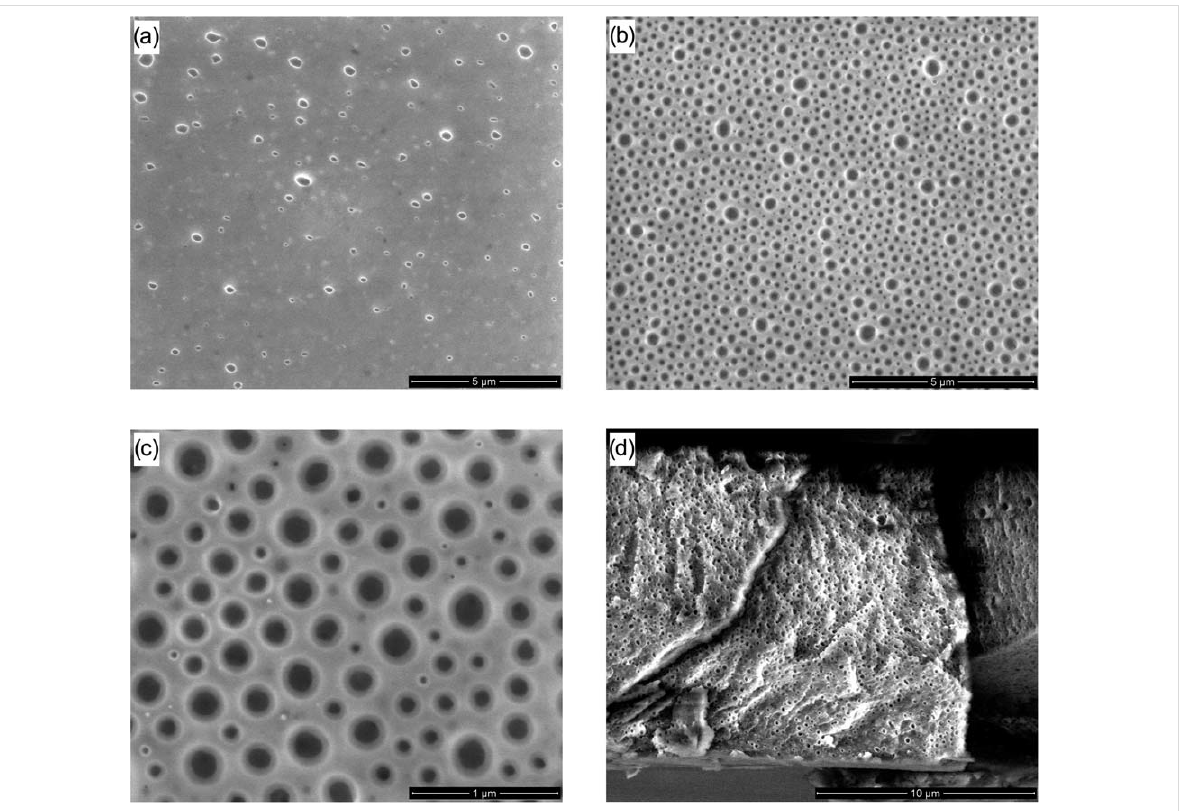
Figure 3: SEM micrographs of PS- b -PEO films after heating at 90 °C and washing with water. a) PS- b -PEO (18.5- b -5.0 kg mol − 1 ). b) PS- b -PEO (10.6- b -5.0 kg mol − 1 ) at low magnification. c) PS- b -PEO (10.6- b -5.0 kg mol − 1 ) at high magnification. d) Freeze fracture cross section PS- b -PEO (10.6- b -5.0 kg mol − 1) . Reprinted with permission from [62], copyright 2011 The Royal Society of